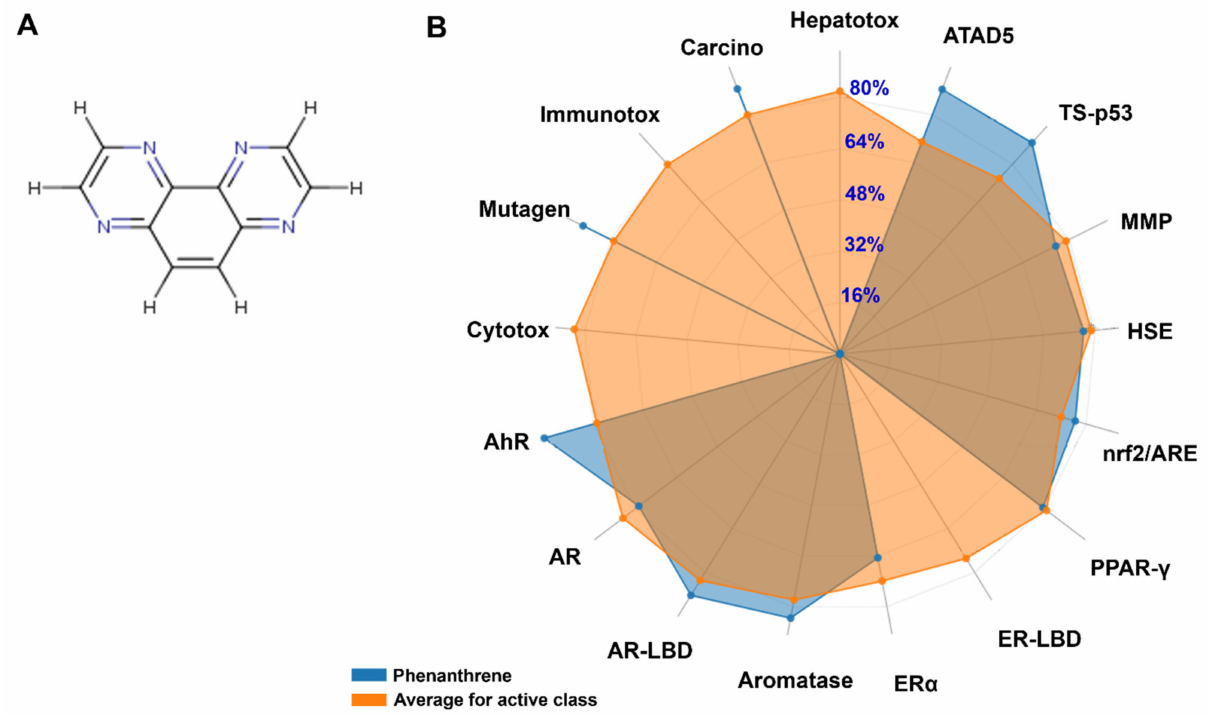
Figure 6. The chemical structure of phananthrene ( A ) and the average biomarker responses related to its toxicodynamics as compared to the average of class compounds ( B ). Cytox: Cytotoxicity; Mutagen: Mutagenicity; Immunotox: Immunotoxicity; Carcino: Carcinogenicity; Hepatotox: Hep- atotoxicity; ATAD5: ATPase family AAA domain-containing protein 5; TS-p53: Tumor Supressor (Phosphoprotein) p53; MMP: Mitochondrial Membrane Potential; HSE: Heat shock factor response element; Nrf2/ARE: Nuclear factor like 2/antioxidant; PPAR- γ : Peroxisome Ploriferator Activated Receptor Gamma; ER-LBD: Estrogen Receptor Ligand Binding Domain; ER α : Estrogen Receptor Alpha; AR-LBD: Androgen Receptor Ligand Binding Domain; AR: Androgen Receptor; AhR: Aryl hydrocarbon